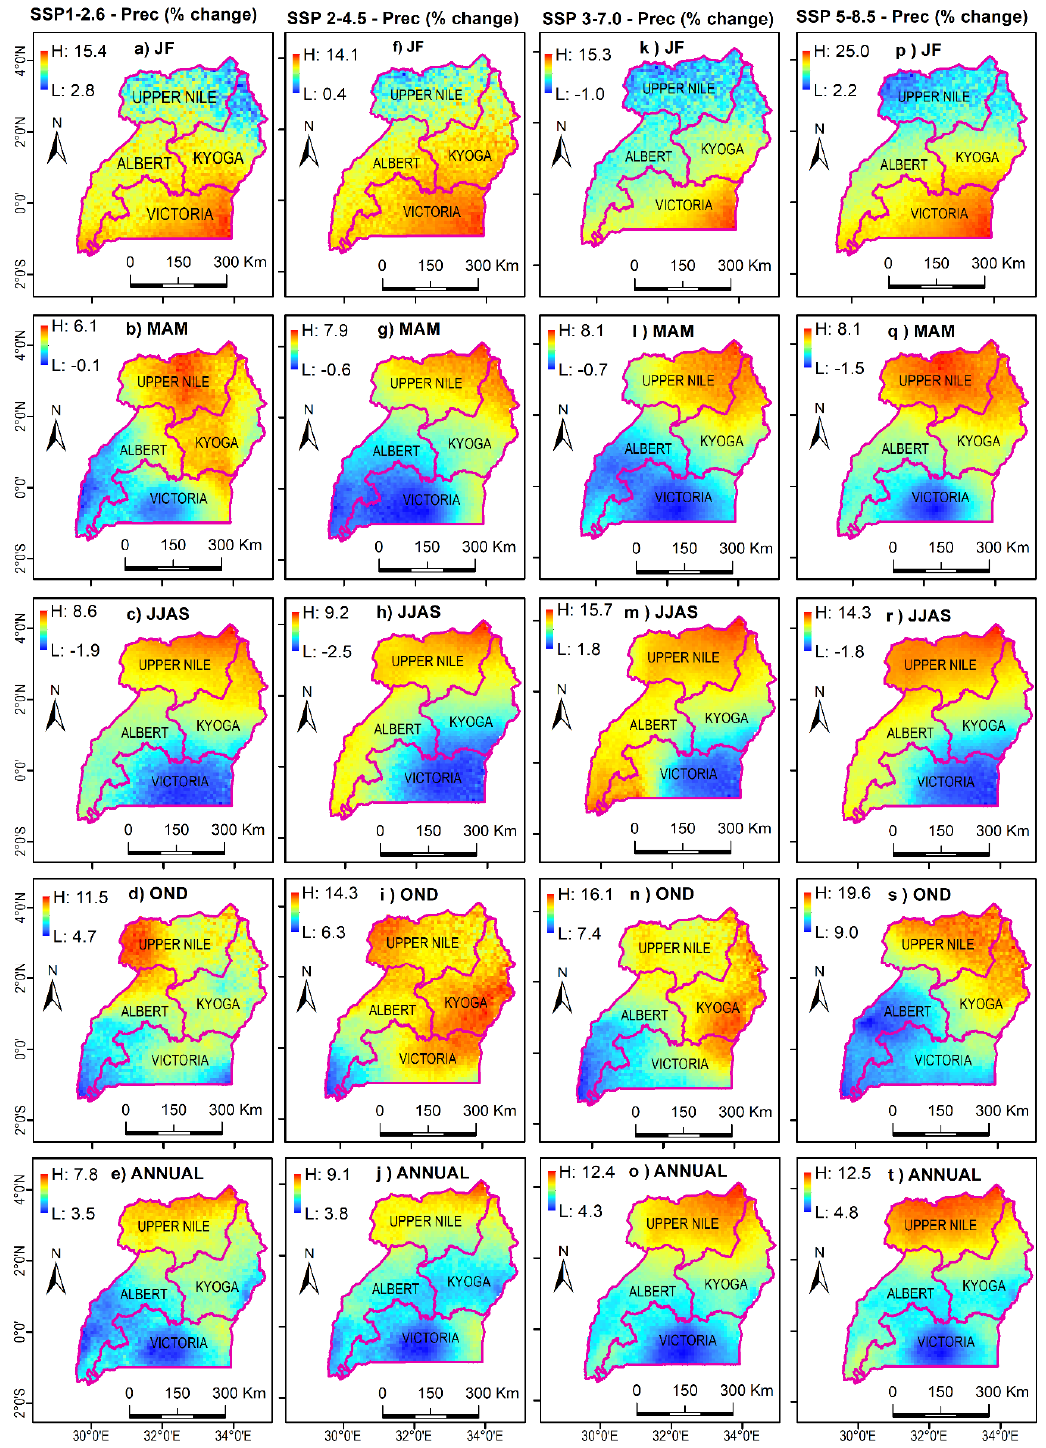
Figure A1. Percentage change in precipitation over the period 2041 – 2060.